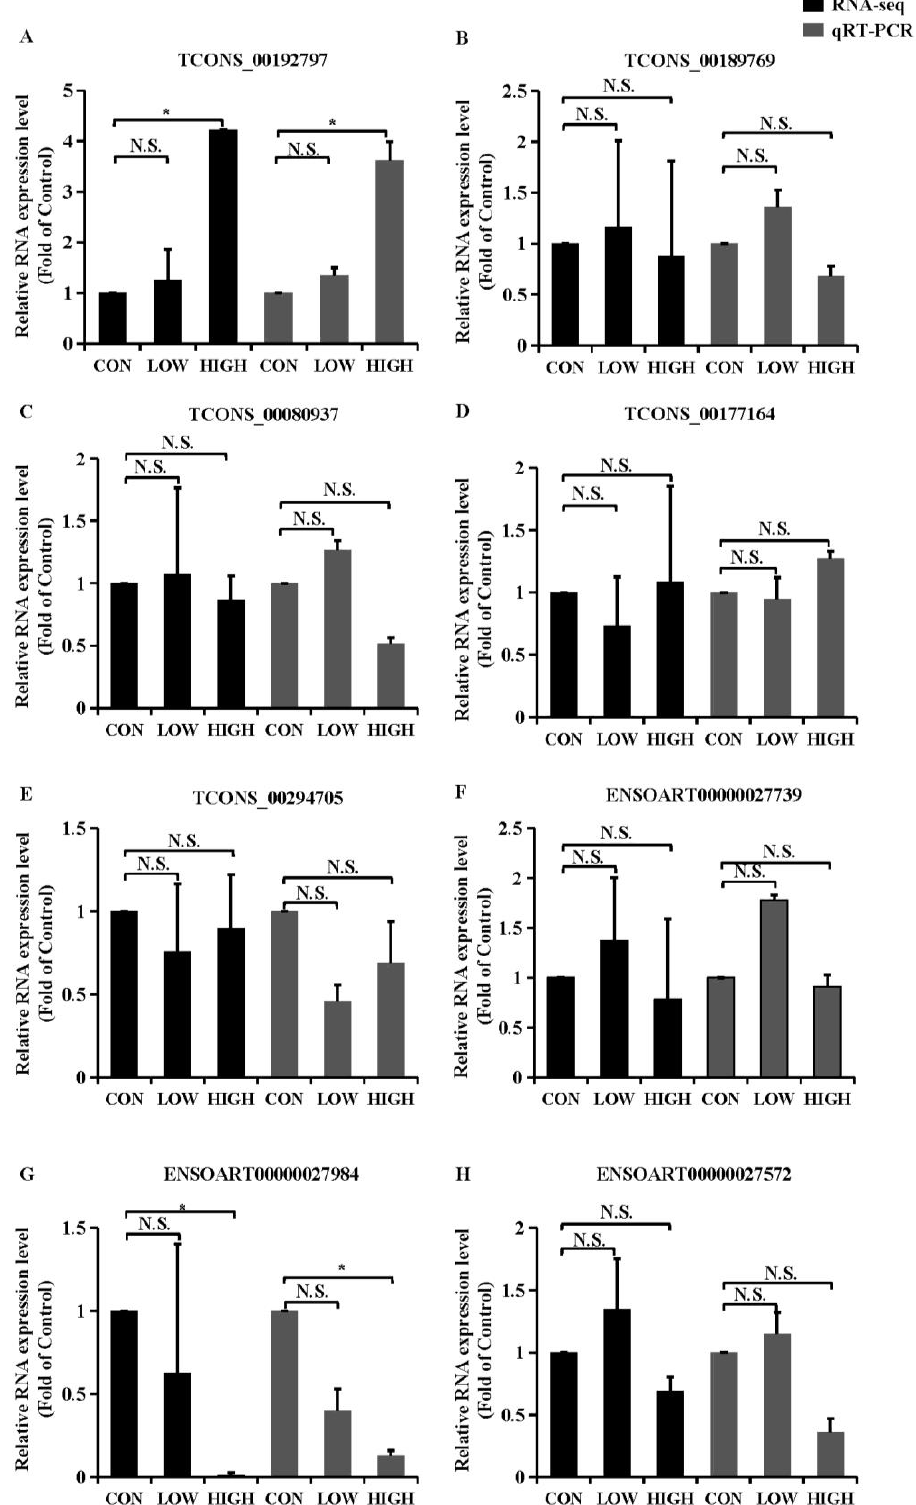
Figure 5. Quantitative real-time PCR (qRT-PCR) validations. ( A–H ) qRT-PCR validations of eight regulated lncRNAs in GCs from in different glucose treatment groups. Values represent means ± SEM for three individuals. * p < 0.05. N.S., not